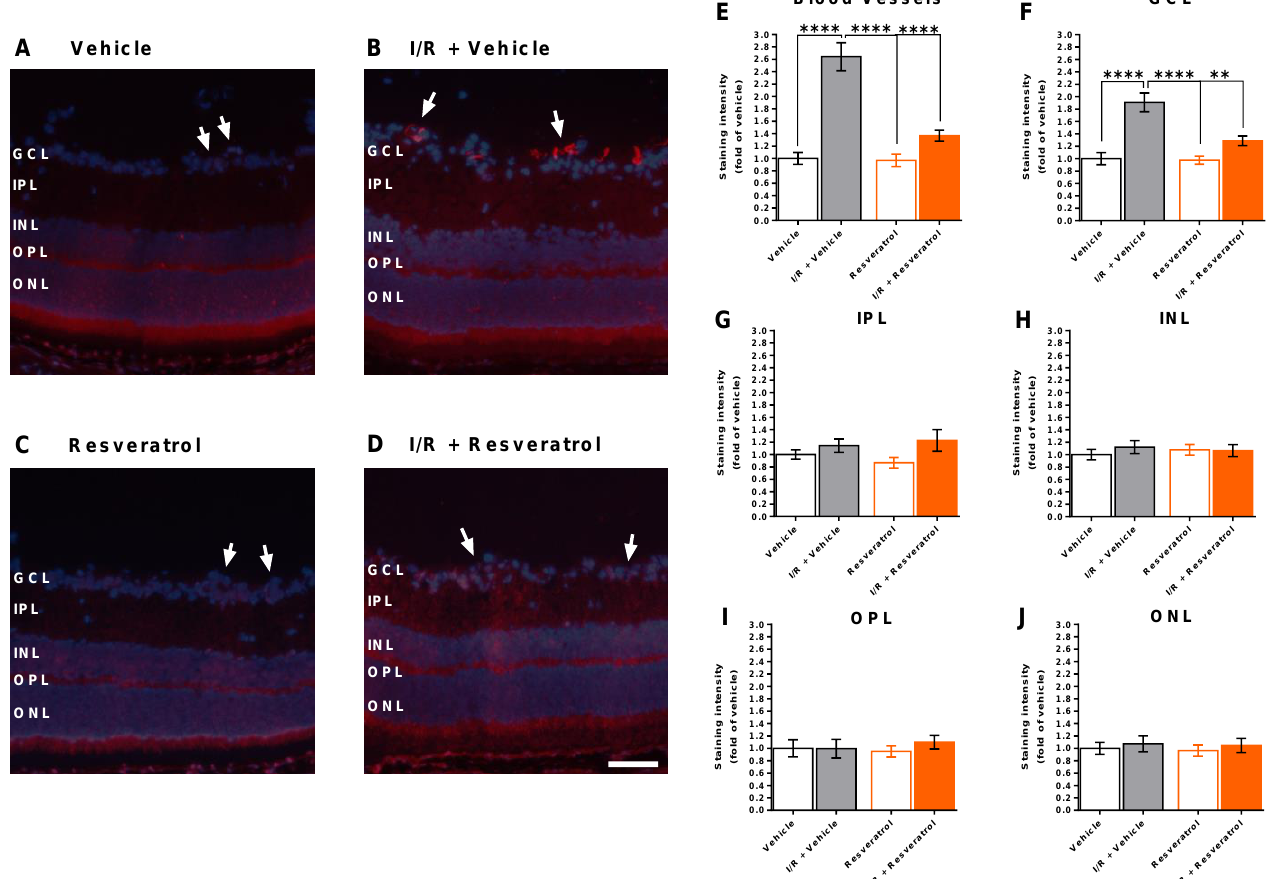
Figure 6. Anti NOX2 staining (red color) in retinal cross-sections. Cell nuclei were visualized with DAPI (blue). ( A – D ) Representative pictures of retinal cross-sections from each group. The white arrows point to the blood vessels. Scale bar = 50 µ m. ( E – J ) Anti-NOX2 staining intensity was increased in retinal blood vessels ( E ) and in the GCL ( F ) from I/R-exposed eyes of vehicle-treated mice. Of note, resveratrol-treatment prevented the I/R-induced increase in anti-NOX2 immunoreactivity ( E , F ). In the IPL ( G ), INL ( H ), OPL ( I ) and in the ONL ( J ) no marked differences in anti-NOX2 staining intensity were observed between the groups. Values are expressed as the means ± SE (**** p < 0.001; ** p < 0.01; n = 8 per group). GCL, ganglion cell layer; IPL, inner plexiform layer; INL, inner nuclear layer; OPL, outer plexiform layer; ONL, outer nuclear layer.